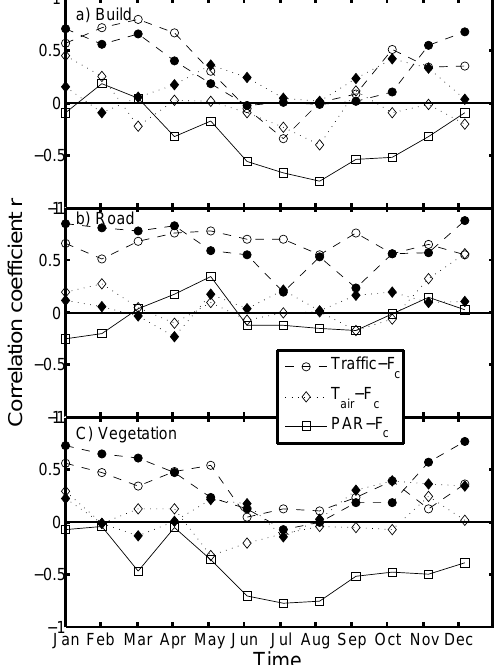
Fig. 11. Temporal variation of the correlation coefficient ( r ) be- tween F c and its environmental drivers: road traffic, air temperature ( T air ) and PAR, for (a) built, (b) road and (c) vegetation surface ar- eas. Open markers are daytime and closed markers night-time cor- relation